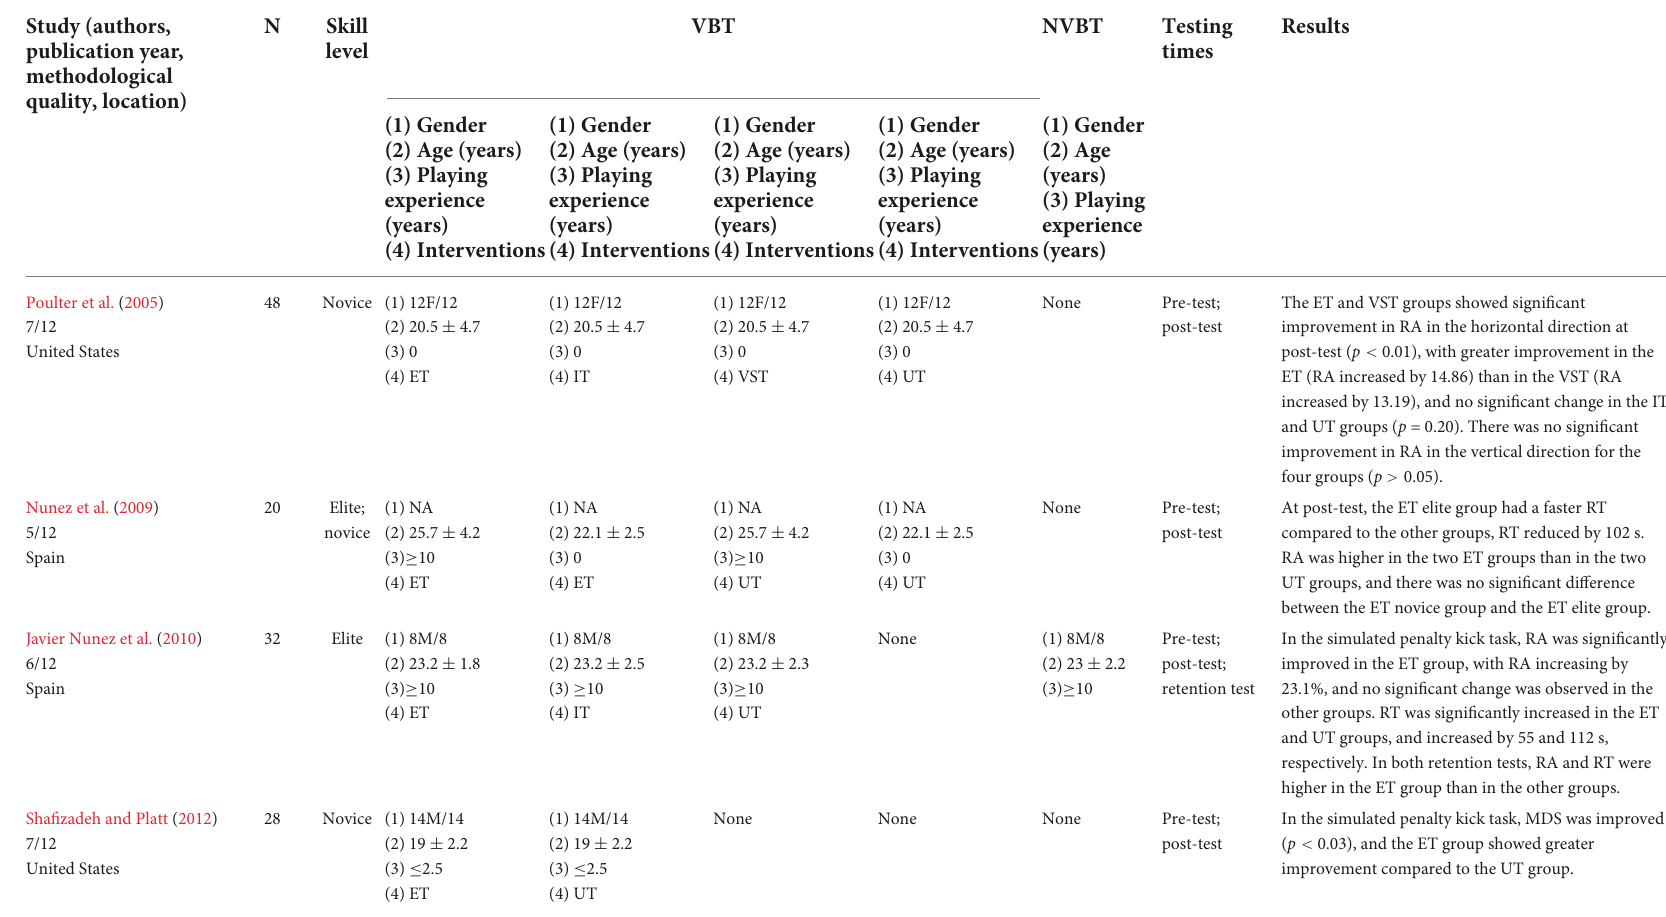
TABLE 2 Characteristics of the included acute